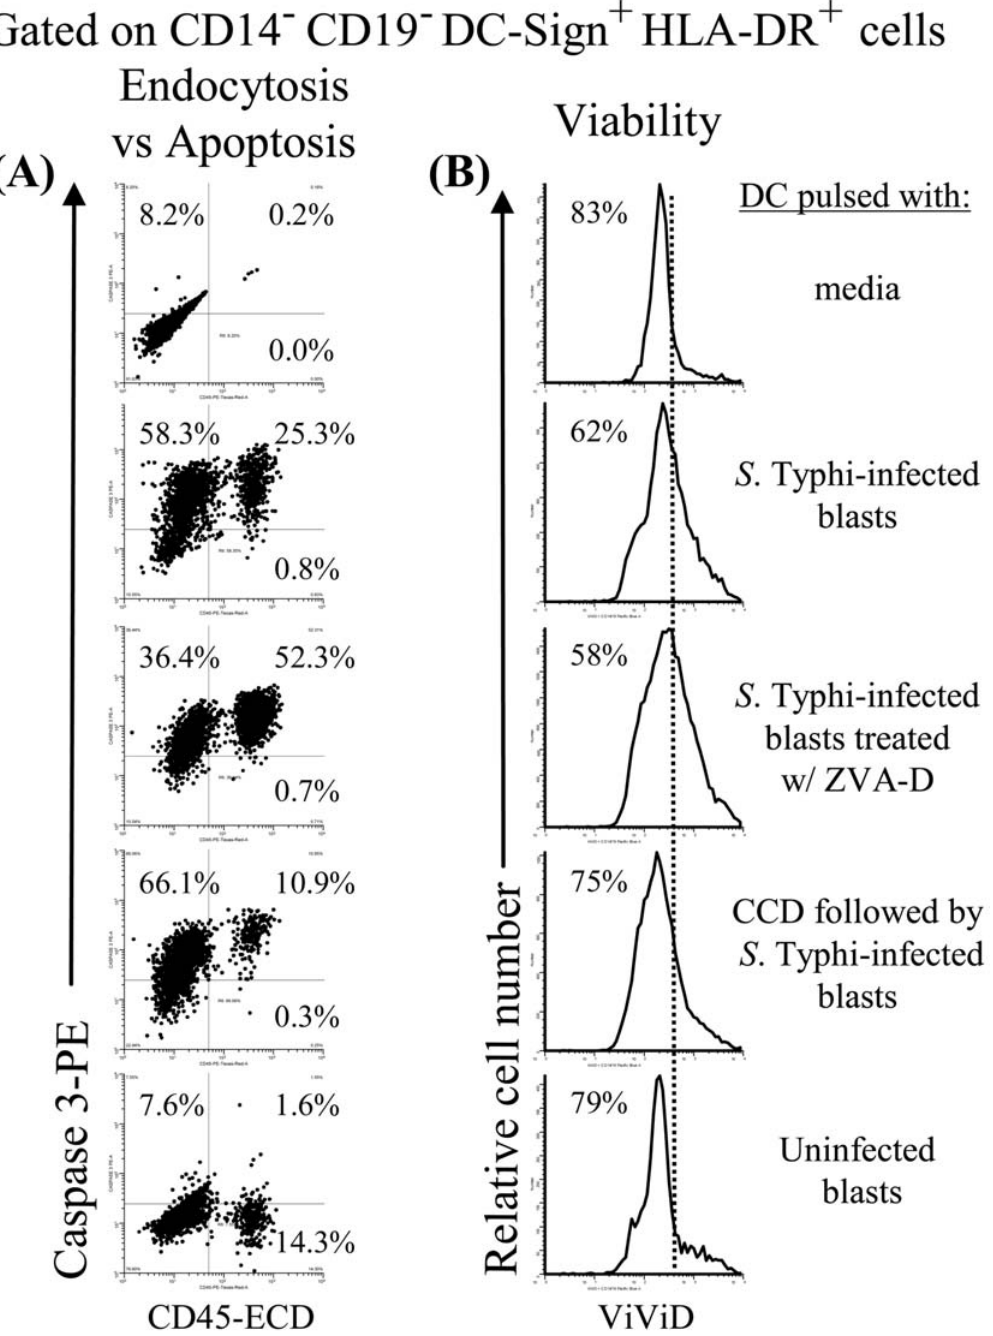
Figure 5. DC efficiently uptake S. Typhi-infected blasts. DC from volunteer CVD4000 # 119 treated or not with ZVA-D or CCD agents were incubated with uninfected or S. Typhi-infected CD45-labeled blasts at a DC:blast ratio of 1:5 at 37 u C. After 2 hours of incubation, DC were stained with ViViD, followed by surface staining with mAbs to HLA-DR, DC-Sign, Salmonella common structural antigens (CSA) and caspase-3 and analysed by flow cytometry. DC were gated based on their scatter characteristics. Single DC were selected by gating on forward scatter height vs. forward scatter area and then on HLA-DR and DC-Sign. ( A ) endocytosis and apoptosis on DC was analyzed by studying expression of CD45 and caspase-3, respectively. ( B ) Viability of DC under different culture conditions was evaluated by ViViD as a dead cell exclusion marker. Dotted lines represent the cut-offs between positive and negative cells. Numbers correspond to the percentage of positive cells in the indicated quadrants or regions in each histogram. These results are representative of 1 of 3 volunteers with similar results.